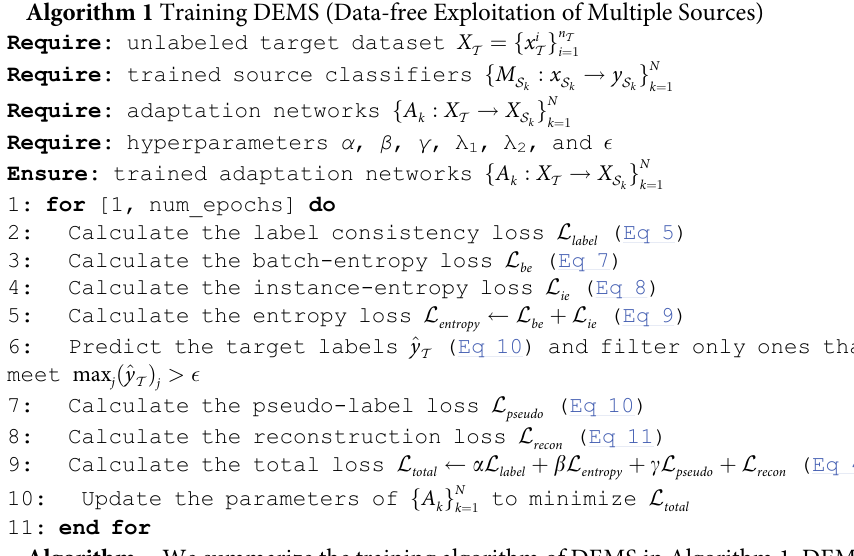
Algorithm. We summarize the training algorithm of DEMS in Algorithm 1. DEMS